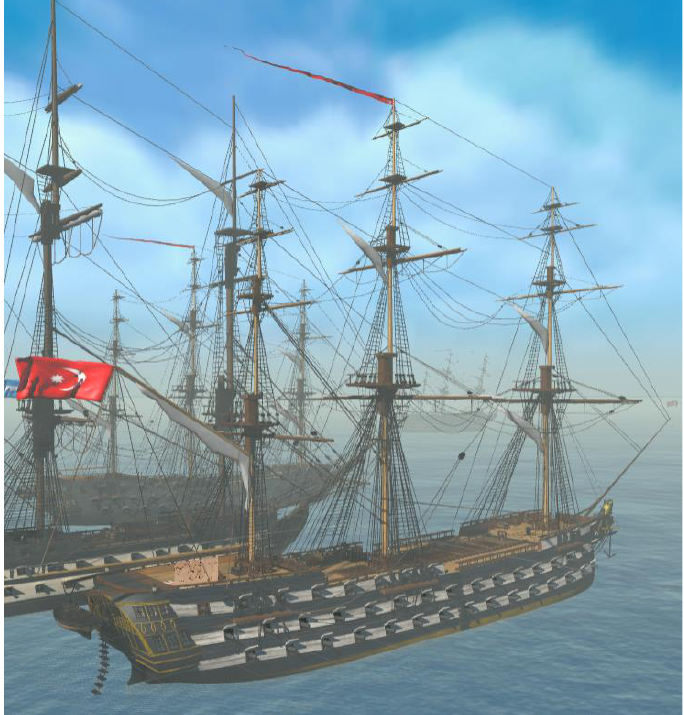
Figure 20 . The Ottoman “Kuh -I- Revan”. Screenshot from Unity3d .